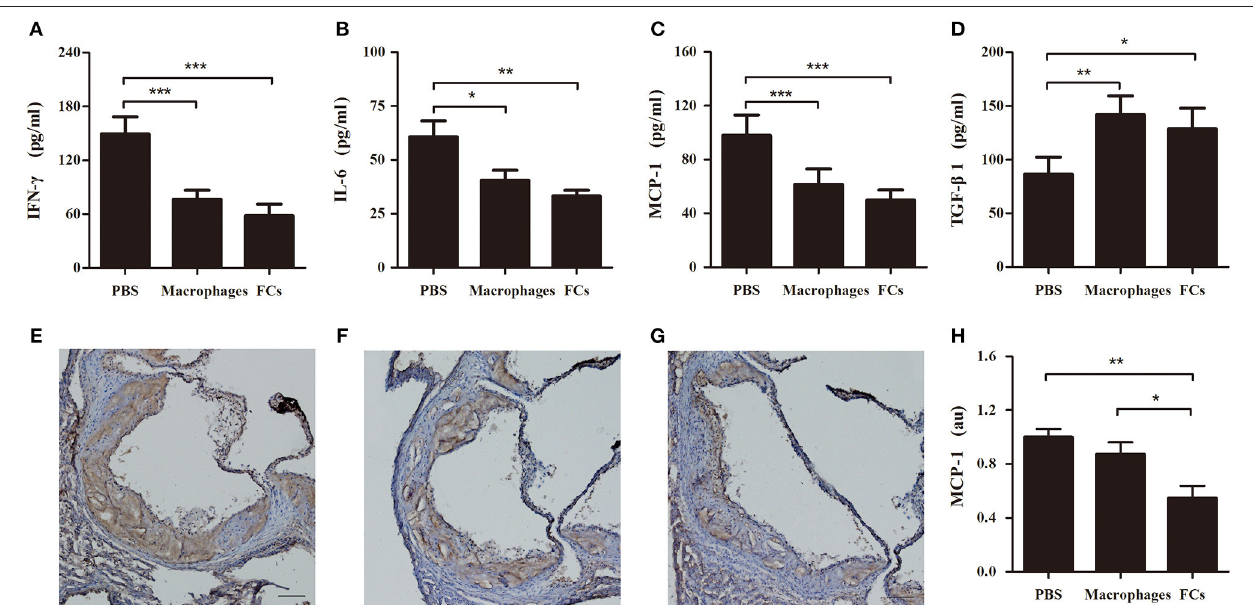
FIGURE 8 | FCs vaccination modulates cytokines in initial atherosclerosis. The levels of IFN- γ (A) , IL-6 (B) , MCP-1 (C) , and TGF- β 1 (D) in immune ApoE − / − mouse plasma were determined at 1:2 dilution by ELISA according to the manufacturer’s protocol. n = 8 in each group. Aortic roots were sectioned and stained with MCP-1. Representative photographs of MCP-1 immunostaining of PBS (E) , macrophages (F) , and FCs (G) immunized mice, respectively. Scale bars, 100 µ m. (H) Quantification of MCP-1 expression in atherosclerotic lesion area of aortic root. n = 6 in each group; * p < 0.05; ** p < 0.01; *** p <